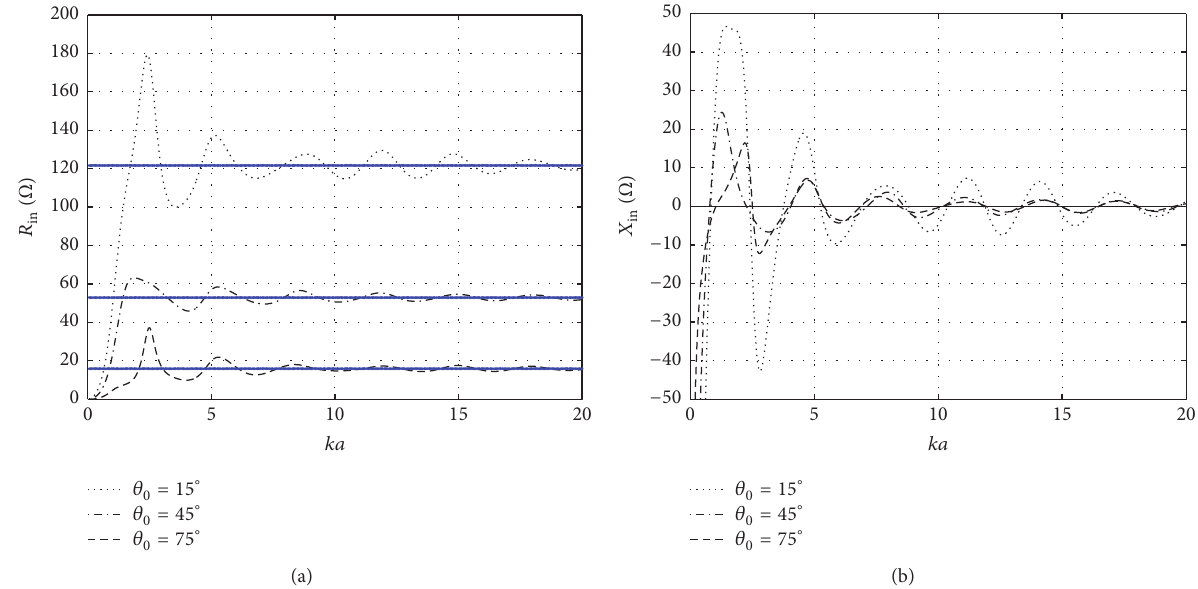
Figure 2: SCCA input impedance versus 𝑘𝑎 for 𝜃 0 = 15 ∘ , 45 ∘ , and 75 ∘ : (a) resistance ( 𝑅 by a solid horizontal line in (a).